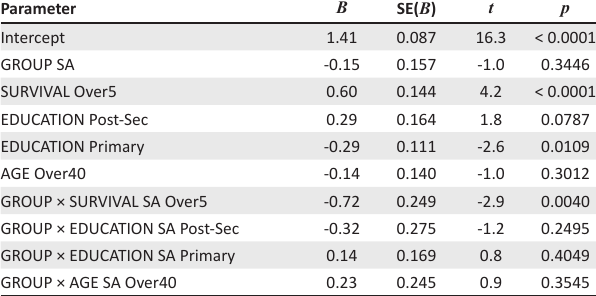
TABLE 11: Parameter estimates for two-way interaction analysis of variance model of customer assistance. Parameter